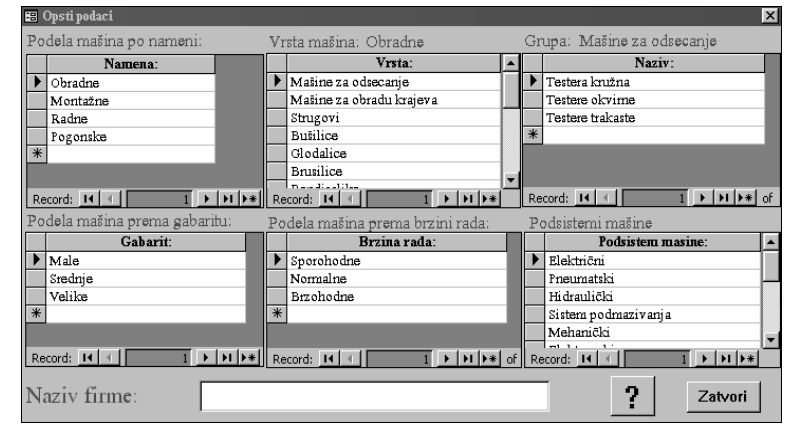
Figure 15 – Example of the window for General data research Рис . 15 – Пример окна для поиска Общих сведений Слика 15 – Пример прозора за претраживање општих